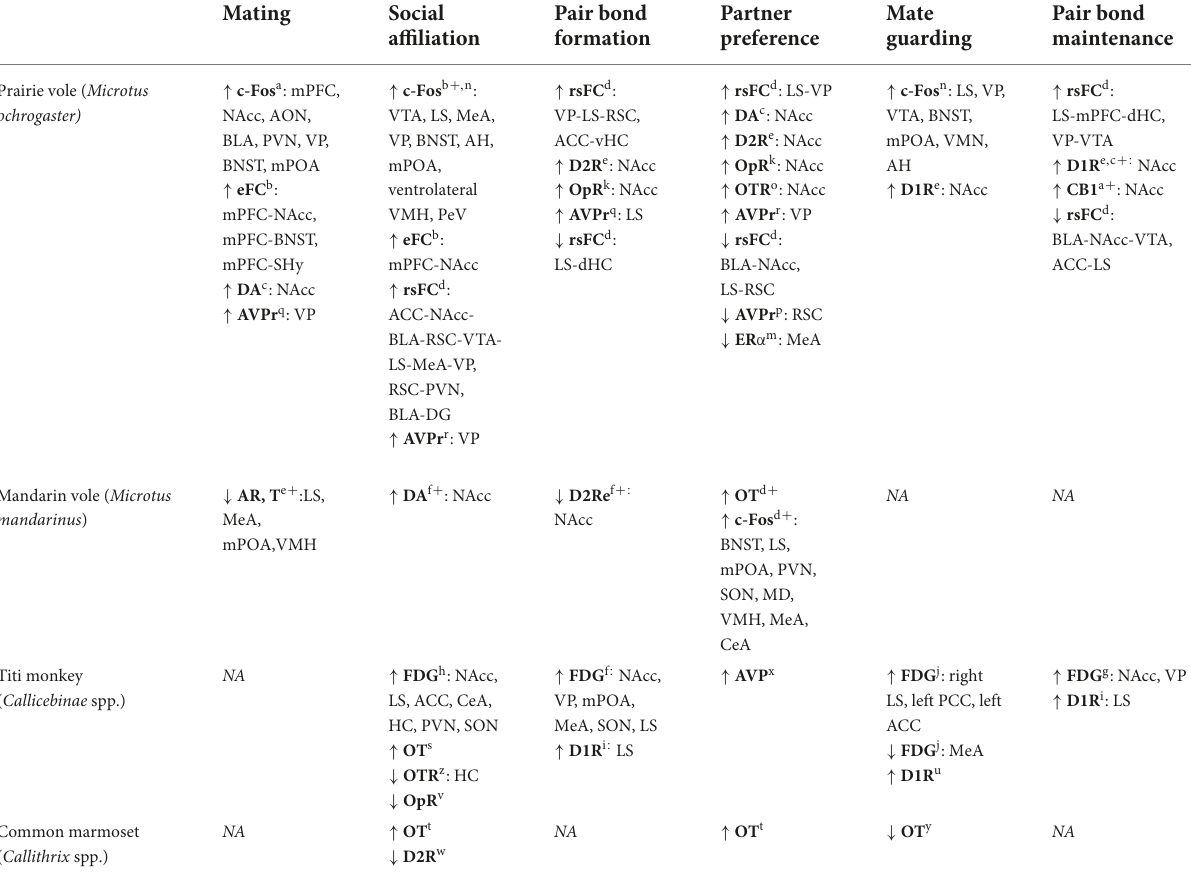
TABLE 1 Species-comparison of known SDMN brain region activity, circuit interactions, and neurotransmission on mating and monogamous behaviors.